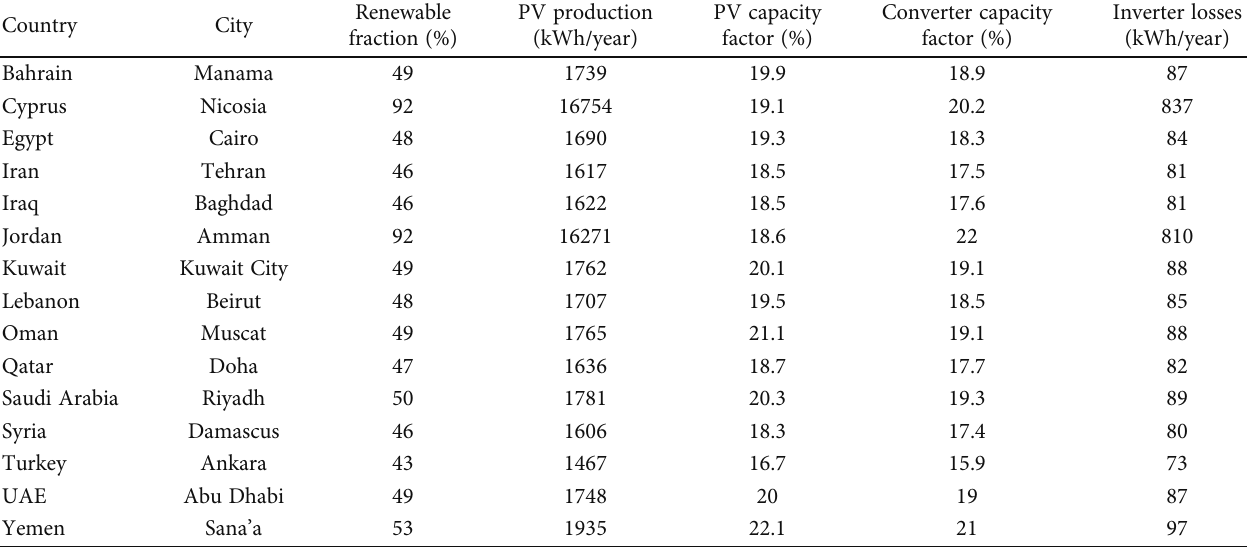
Table 6: Results of energy assessment.